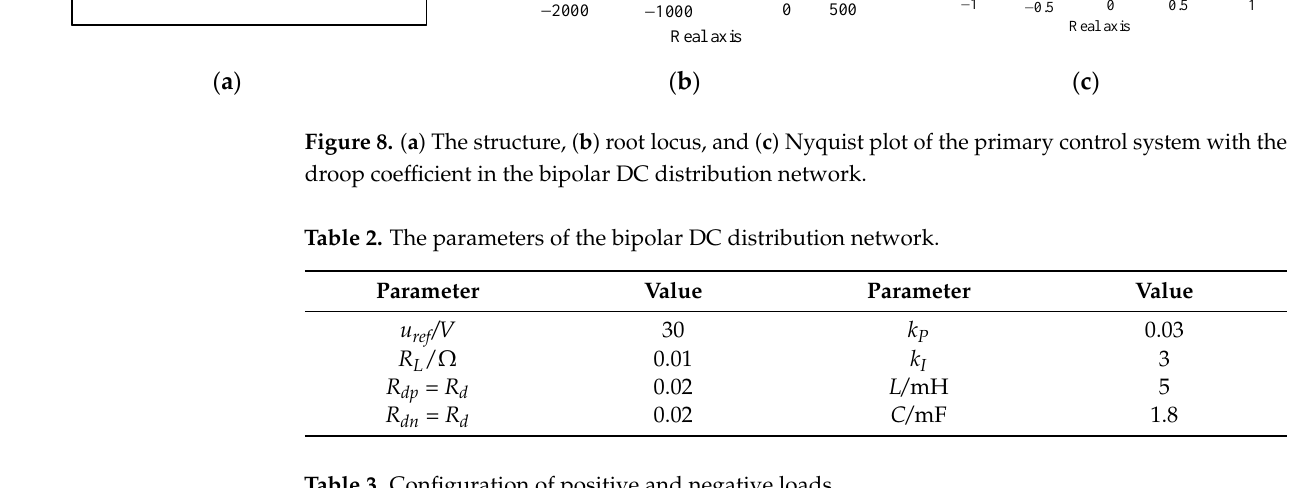
Table 3. Configuration of positive and negative